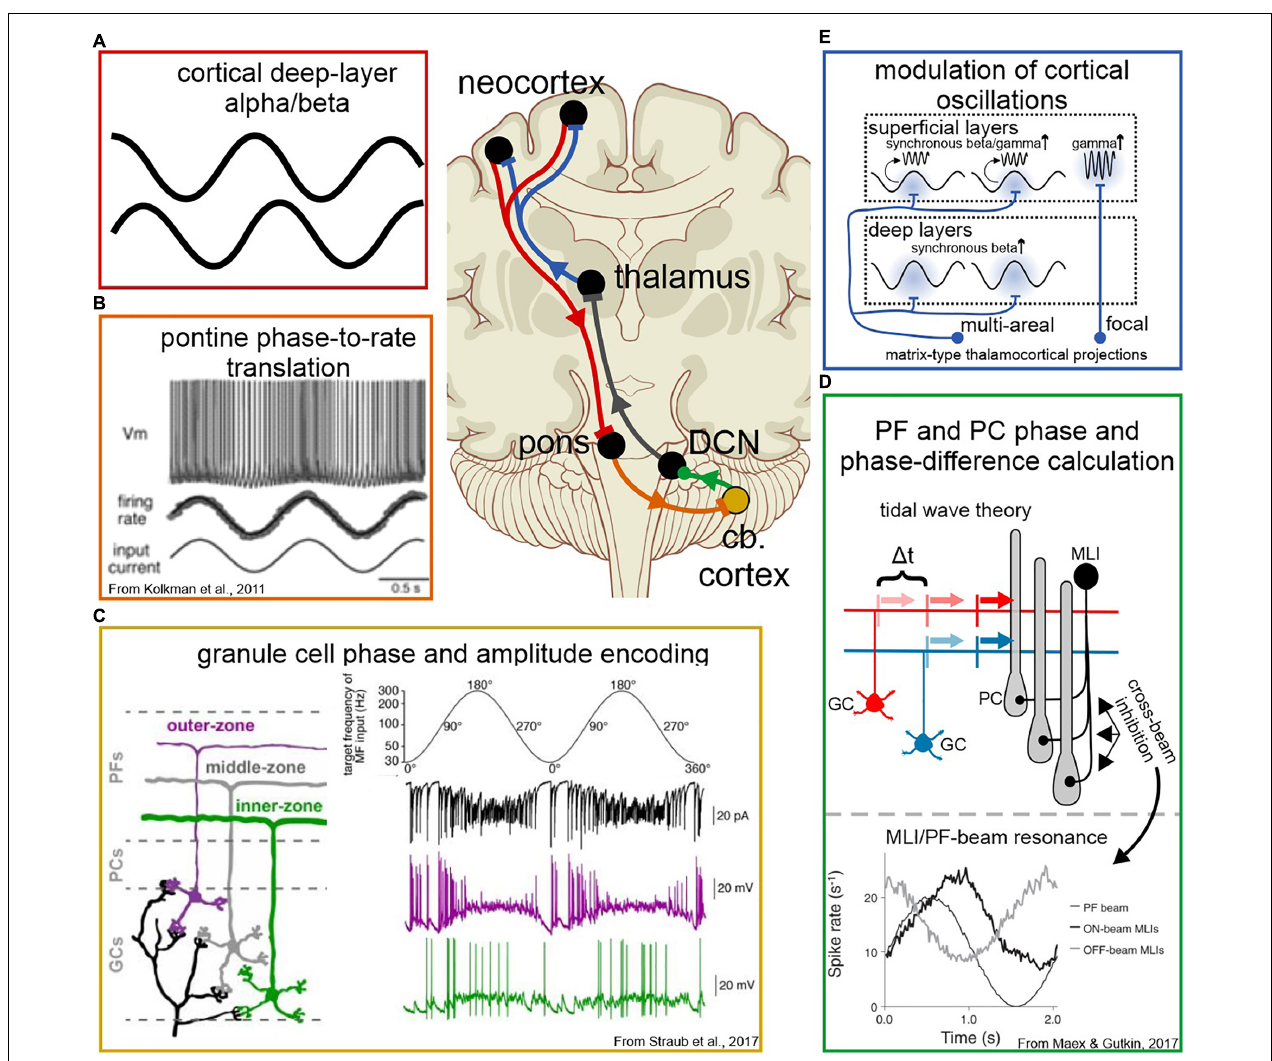
FIGURE 4 | Cellular and network mechanisms of oscillatory encoding and modulation in the cortico-cerebello-cortical circuit. Panel labels are color-coded according to where in the circuit a modulation of the neuronal signal occurs, corresponding to the schematics in the top-center. (A) Cortico-cerebellar signals originate in the deep layers of the neocortex, where alpha and beta oscillations predominate. (B) Pre-cerebellar neurons in the pons translate a dynamic current input into rate in a linear fashion, thereby translating oscillatory current into a rate code. (C) Deep and superficial GCs respond preferentially to different phases of the ponto-cerebellar signal, thereby encoding both phase ( via time) and amplitude ( via GC depth) of oscillatory input. (D) Phase and phase difference of oscillatory activity is decoded by Purkinje cells, via two potential mechanisms. Top: tidal wave theory proposes that a phase difference in a band-limited frequency range can be calculated as a time difference along slow-conducting parallel fibers. Each parallel fiber conveys information about the phase of one cerebral oscillation, and together convey information about the phase relationship of their inputs. Two inputs offset by (cid:49) t would arrive simultaneously at the Purkinje cell dendritie. Bottom: simulations show that rhythmic excitation can generate network resonance across parallel fiber beams with a phase shift, due to cross-beam inhibition from MLIs. Rhythmic excitation could augment Purkinje cell responses to input across parallel fiber beams, thereby providing a means to calculate phase differences that are too great to be accounted for in parallel fiber conduction length. (E) Feedback to the cortex conveyed via thalamocortical projections. Multi-areal matrix-type projections target superficial and deep layers in multiple cortical areas, likely inducing simultaneous beta oscillations that facilitate simultaneous gamma bursts in targeted regions. Focal matrix-type projections preferentially target the superficial layers, suggesting a role in spatially selective augmentation of gamma responses during the bottom-up flow of